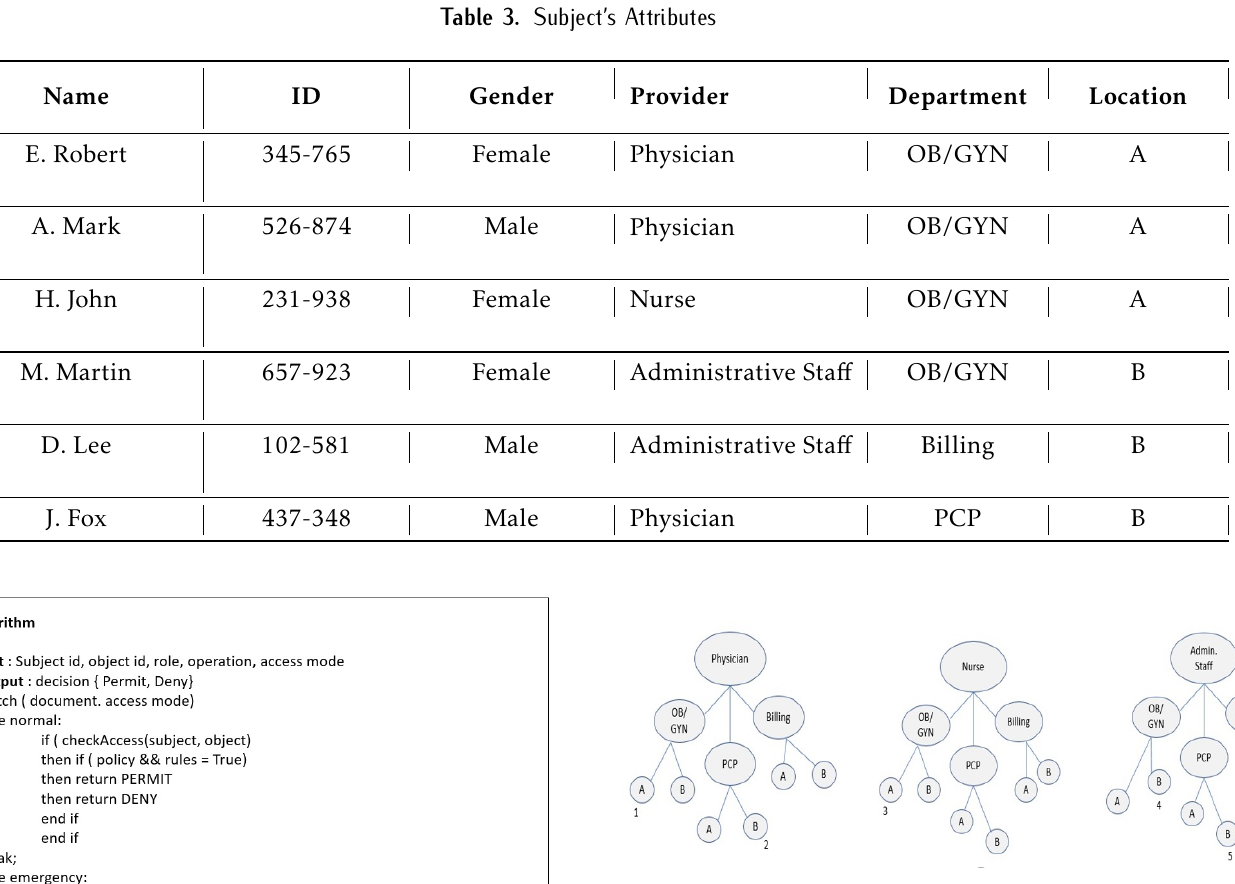
Figure 6. Pseudorole generation in MLAC